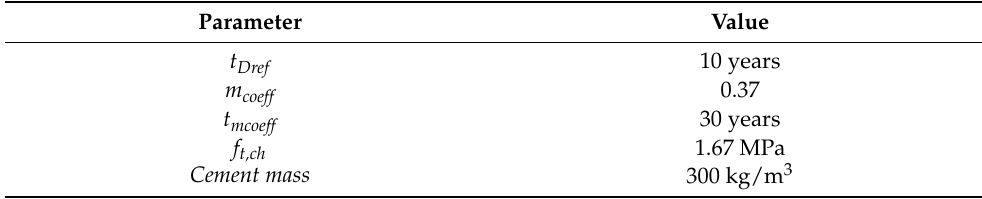
Table 4. Other chloride-induced corrosion